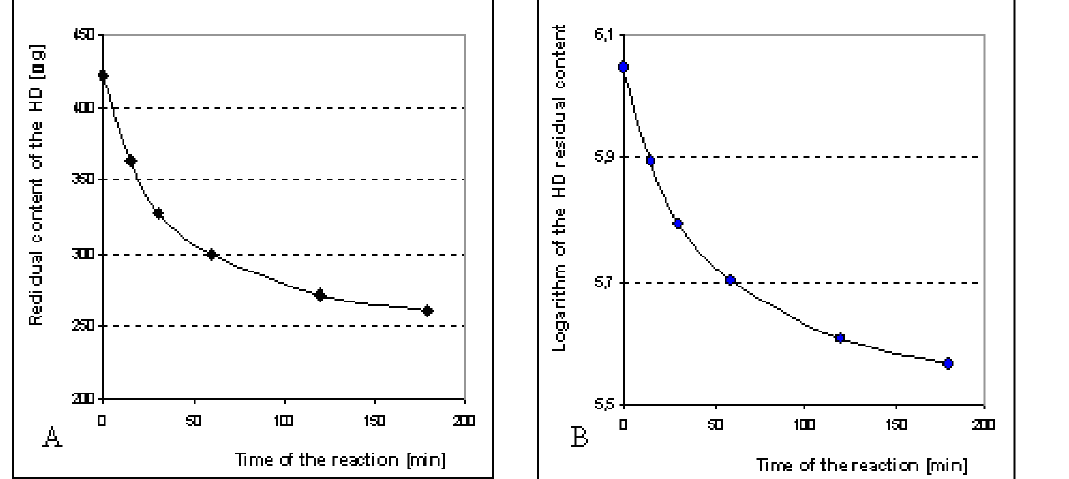
Fig. 4 Time dependence of the HD conversion on the Mg 25/2/380